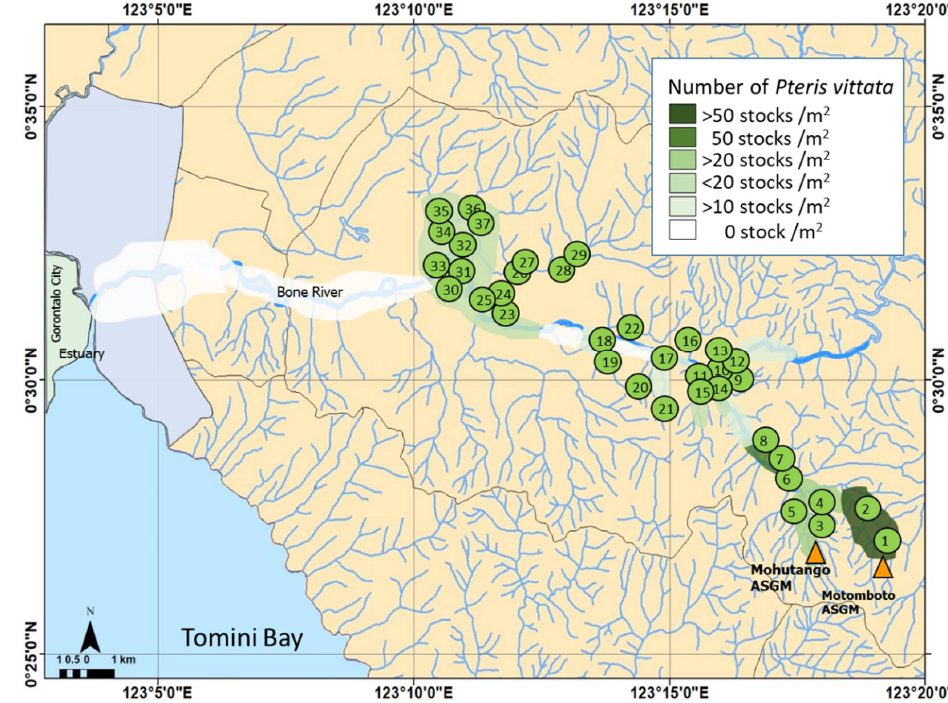
Figure 3. P. vittata distribution map and sampling point.